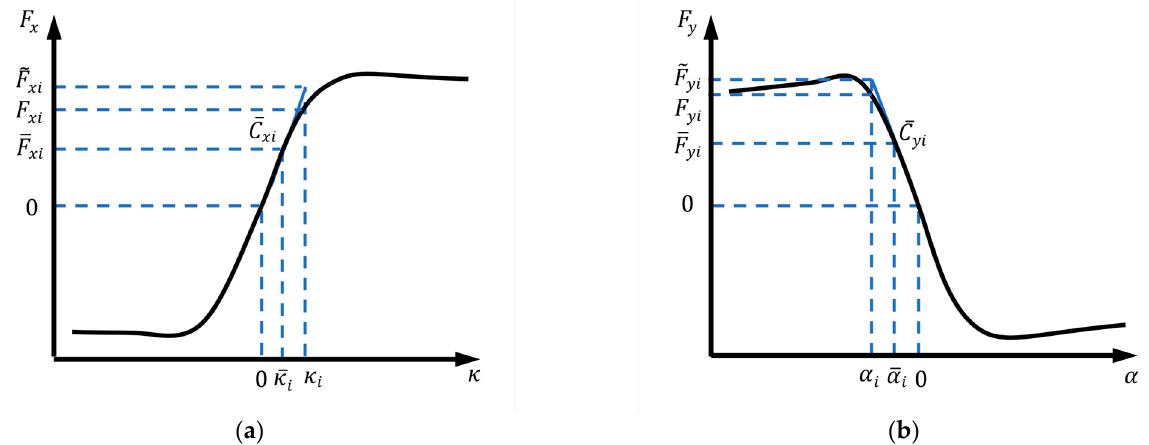
Figure 3. UniTire tire model with affine approximation: ( a ) longitudinal force; ( b ) lateral force.